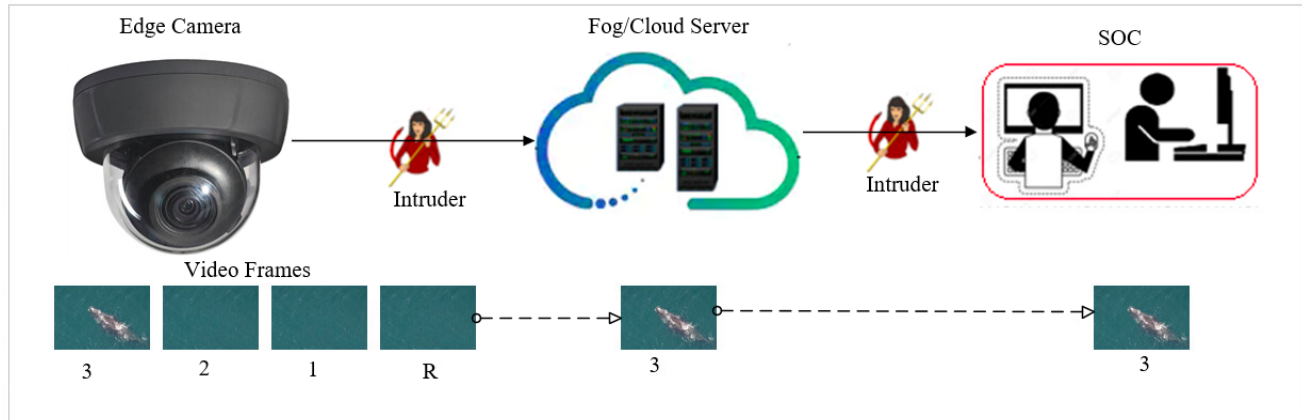
Figure 3. An illustration of foreground object detection and discarding of a frame containing only background